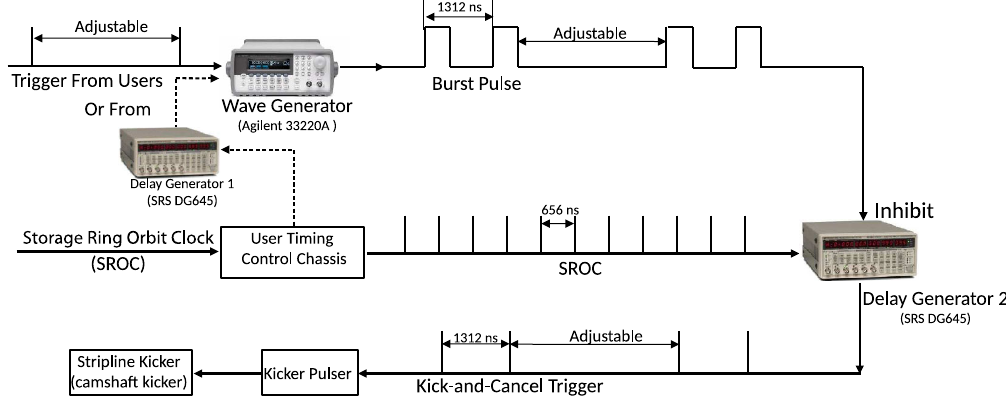
FIG. 6. Schematic of pulser timing setup for the kick-and-cancel operation at tune 0.25